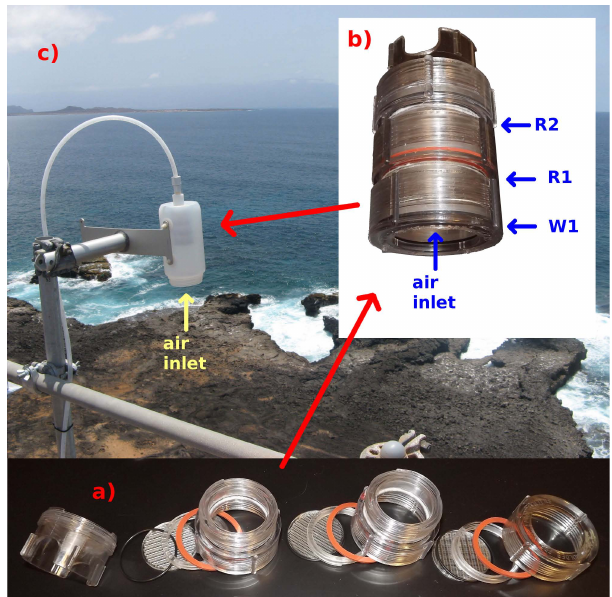
Figure 5. Filter packs: (a) individual pieces (without filters); (b) as- sembled filter pack with positions of the Whatman (W1) and Rayon (R1, R2) filters indicated; (c) deployment at the Cape Verde sam- pling